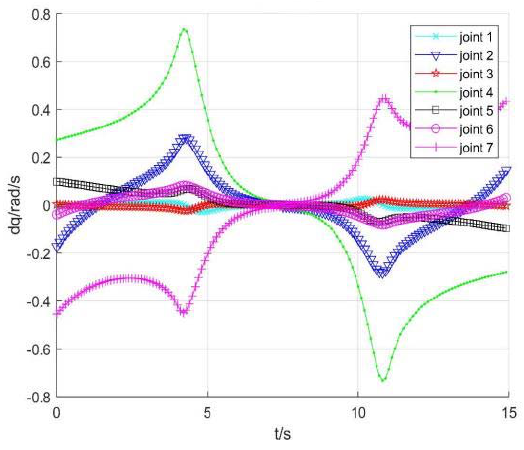
Figure 14. Velocity variation of robot joints.